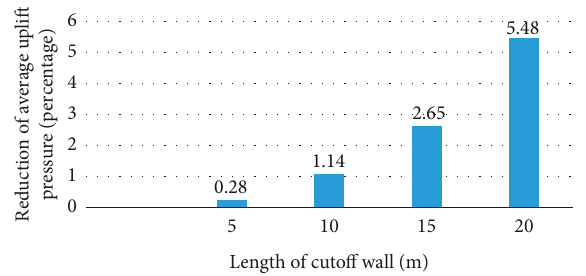
Figure 7: Percentage reduction of average uplift pressure.